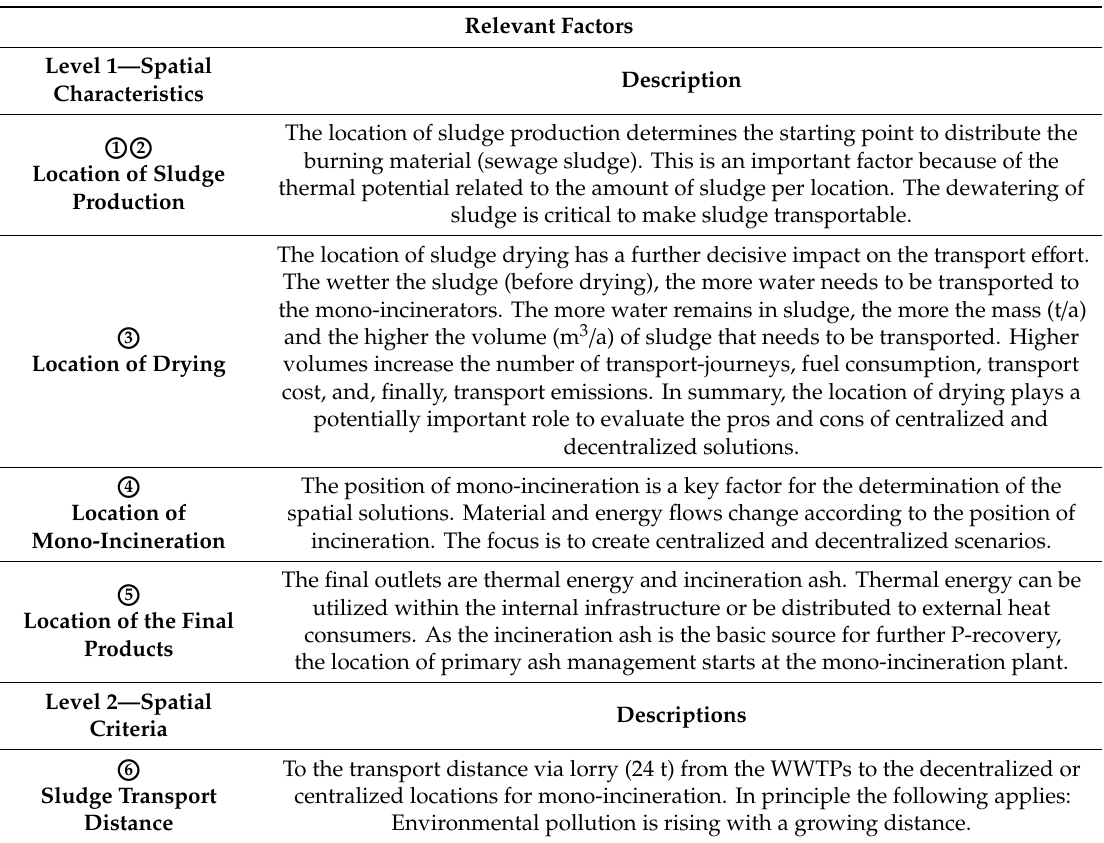
Table 3. Relevant factors for the development of scenarios divided into level 1 (spatial characteristics) and level 2 (spatial criteria). WWTP: wastewater treatment